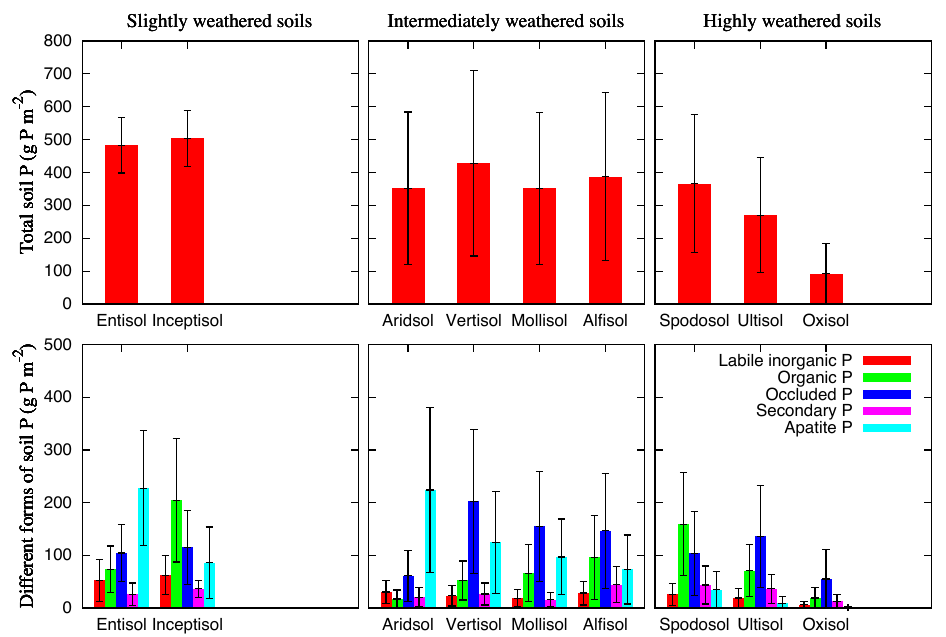
Fig. 5. Estimated soil P content (gPm − 2 ) to 50cm depth of soil for soil orders in three soil weathering categories. The uncertainty of these estimates is indicated by the standard deviations, which is calculated based on the uncertainty of PPDI (Table 2), the uncertainty of Hedley fractions (Table S2), and the uncertainty of soil strain (Table 3). PPDI (phosphorus pedogenic depletion index) is an estimate of the accumulated loss of parent material P during